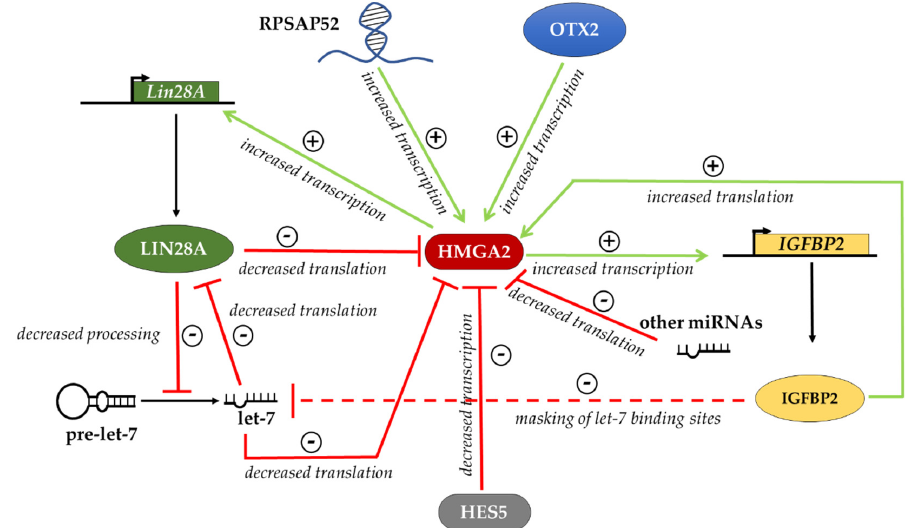
Figure 1. Regulatory network controlling HMGA2 protein levels. HMGA2 levels are regulated by RNA binding proteins, like IGF2BP2 and LIN28, which, through the interaction with the HMGA2 mRNA, increase or decrease the translation, respectively. HMGA2 expression is also downregulated by HES5 at the transcriptional level and by let-7 and other miRNAs at the post-transcriptional level. The sign + indicates improved expression of the target, the sign – indicates impaired expression of the target.